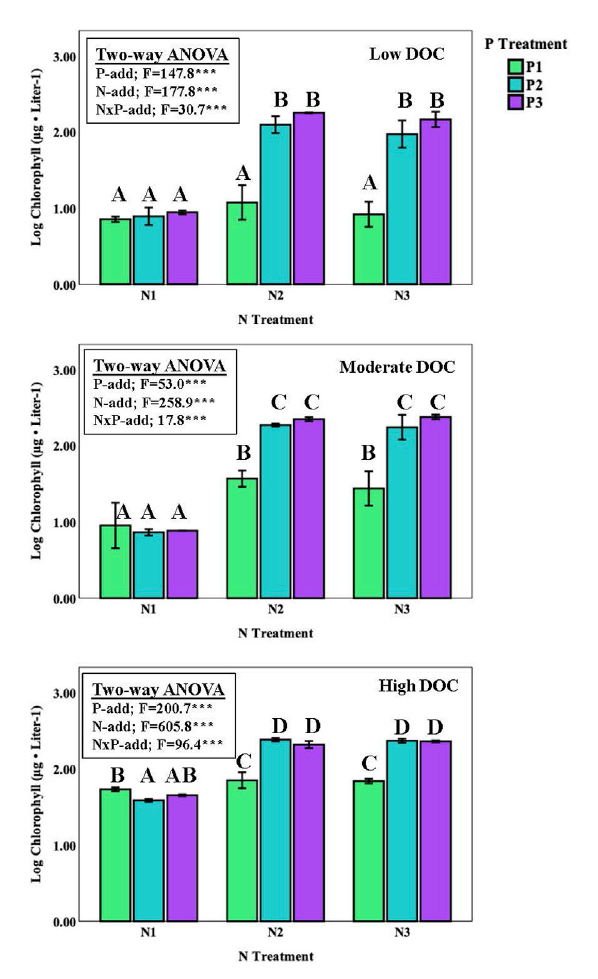
FIGURE 3 Chlorophyll concentrations (average ± one standard error) for suspended algal assemblages in response to varying levels of N and P enrichment (9 nutrient spike treatments). Common lettering joins treatments where no signi fi cant differences were observed (TukeyHSDpairwisecomparisons, p < 0.05).OnewayANOVAwasrun separately (blocked) for site and nitrogen